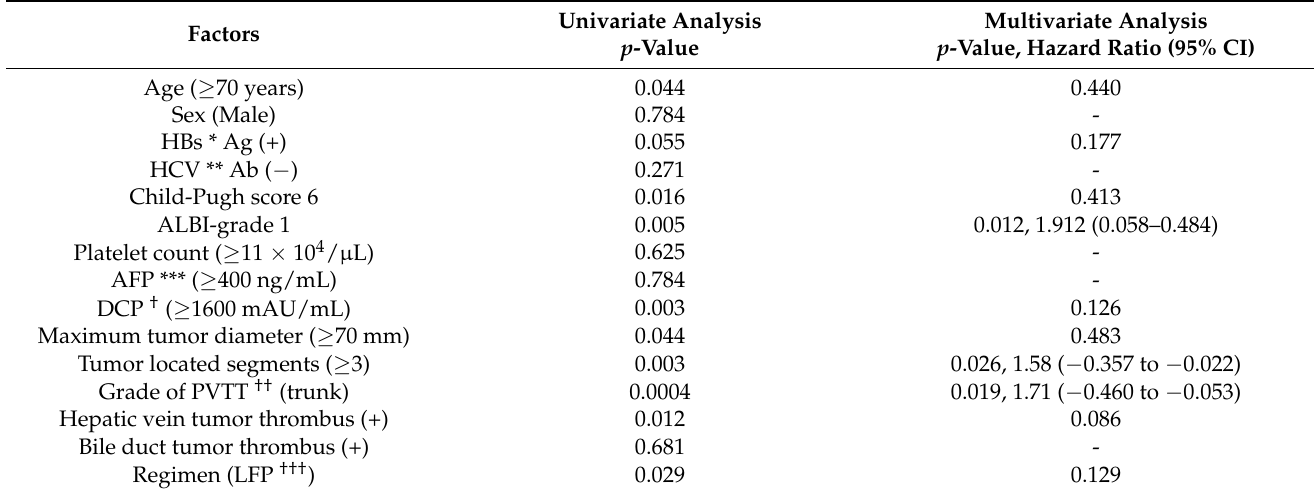
Table 3. Univariate and multivariate analysis of the factors associate with poor survival of the patients treated with either LFP or New FP ( n =